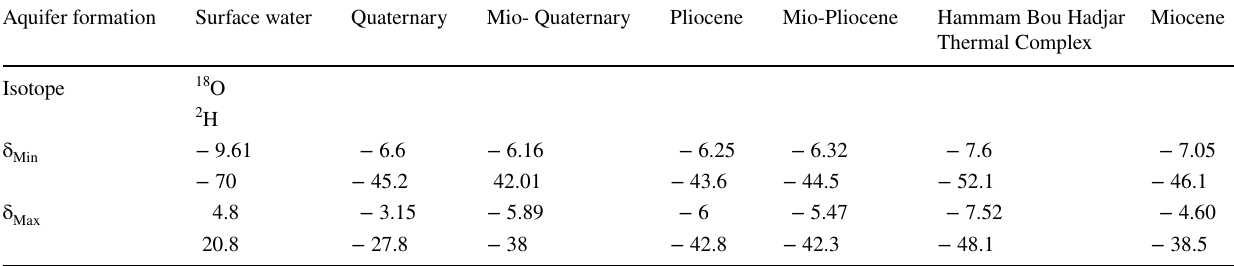
Fig. 3 Diagram δ 2 H—δ 18